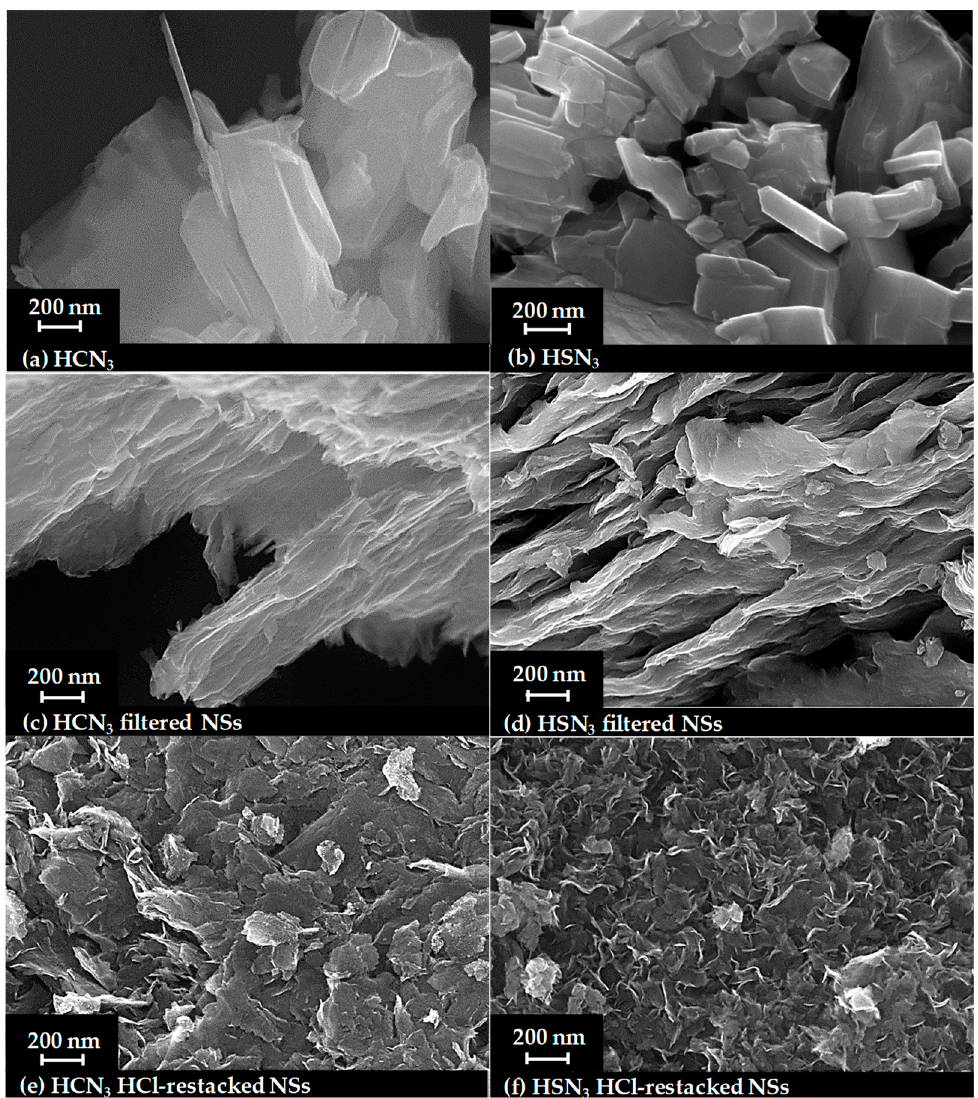
Figure 5. SEM images of the protonated niobates ( a , b ), their filtered ( c , d ) and HCl-restacked nanosheets ( e , f ).